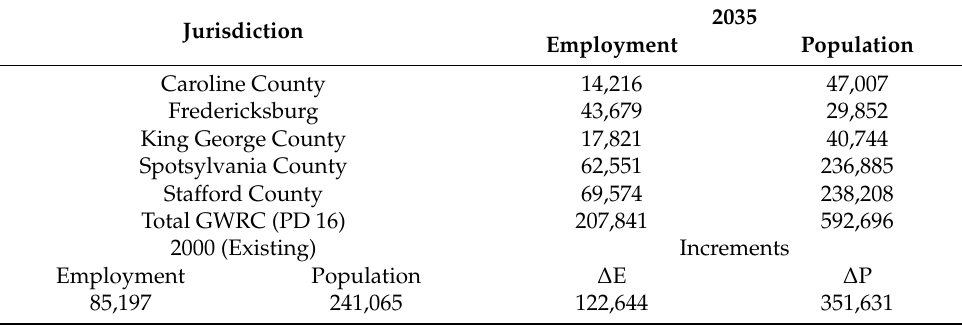
Table 10. Target Population and